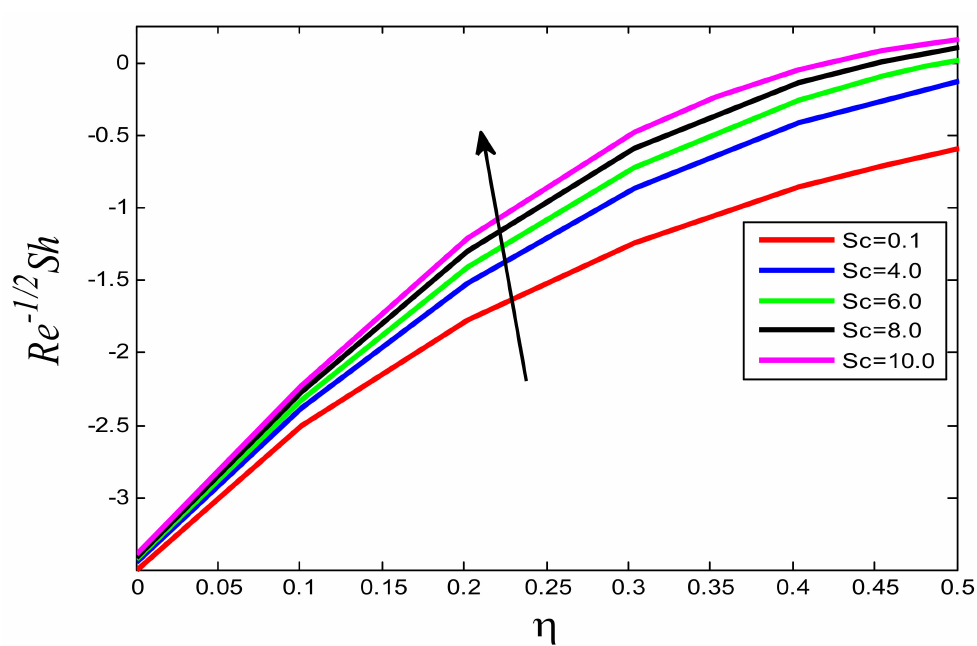
Figure 33. Influence of Sc on Re − 1/2 Sh